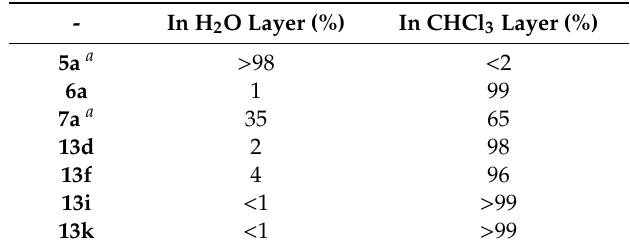
Figure 2. Photos of mixtures of 2 (Zn 2 L 2 ), the complexes of 2 with barbital derivatives ( 4a , 11d , 11f , 11i , and 11k ) ( 6a , 13d , 13f , 13i , and 13k ), and the 2:2:2 complexes of 2 , Bar units and Cu 2+ ( 9a , 16d , 16f , 16i , and 16k ) in CHCl 3 /50 mM HEPES buffer (pH 7.4) with I = 0.1 (NaNO 3 ) (1/1) at room temperature. Table 1. Distribution of each complex ([ 6a , 13 ] = 20 µ M in the total solvent including both the aqueous and the CHCl 3 phase) in the aqueous layer and the organic layer, as estimated by UV/Vis absorption spectra of these complexes in each layer.